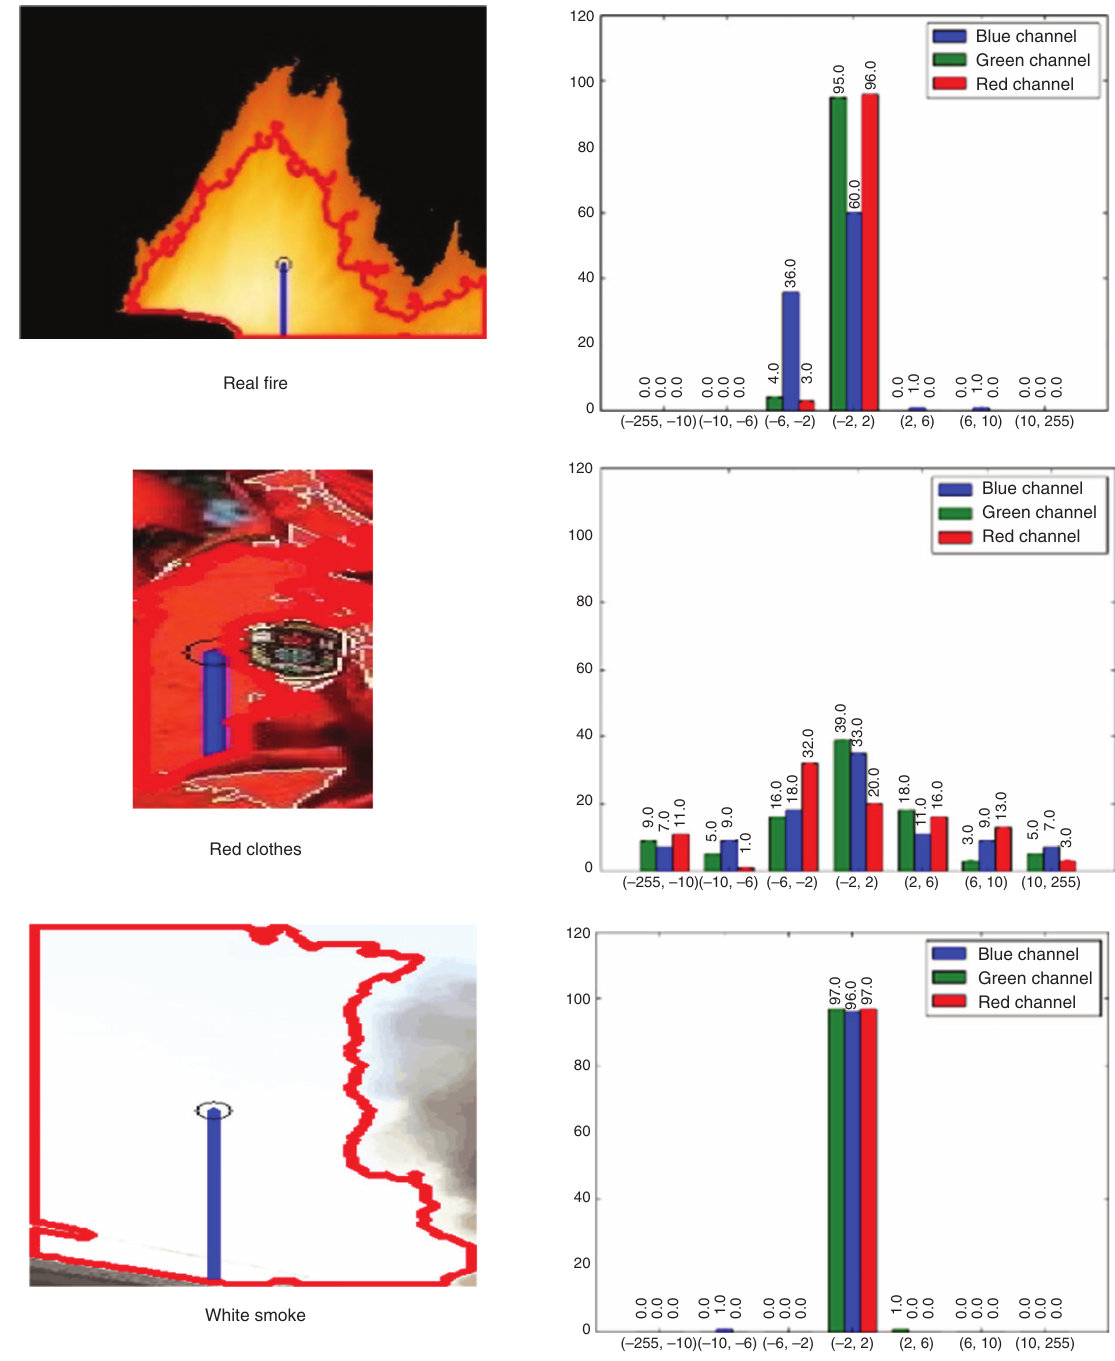
Figure 9: Pixel Value Gradient Distribution Range for Flame and Non-flame Regions.